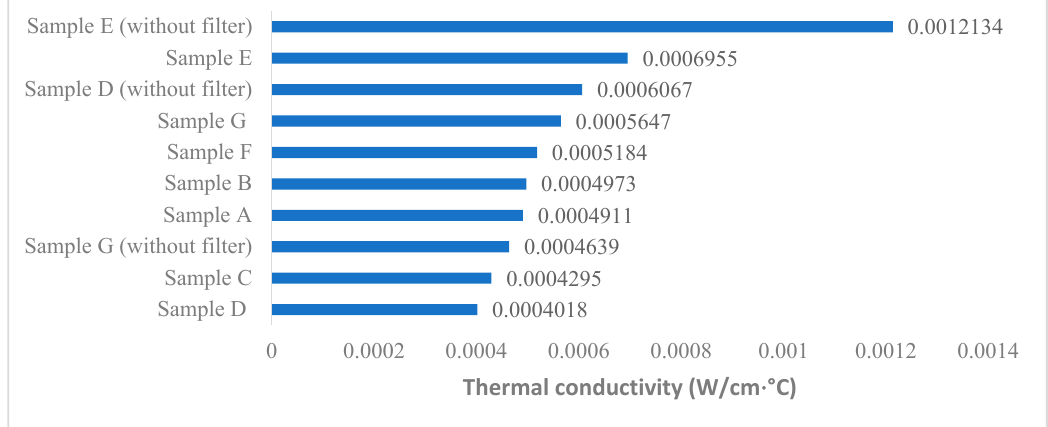
Table 3. Correlation between different test results.